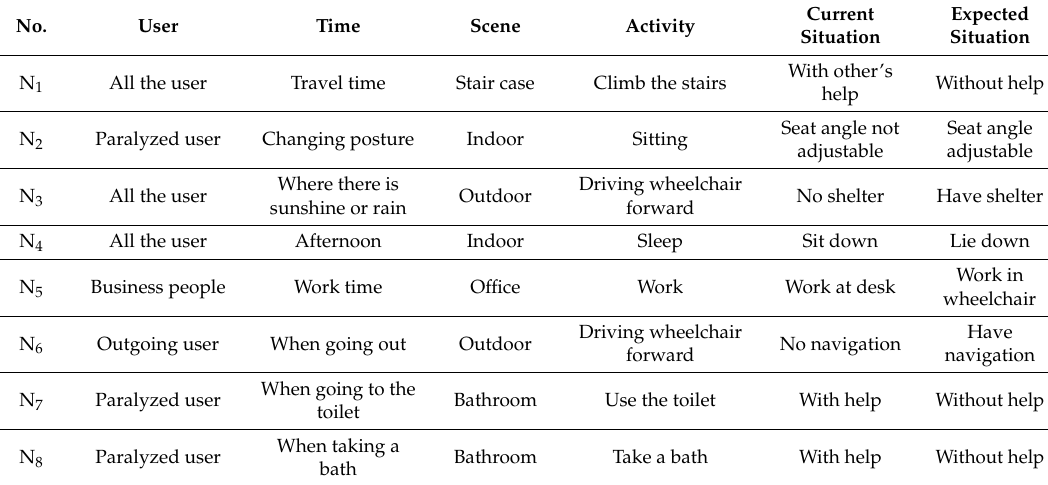
Table 3. User needs.